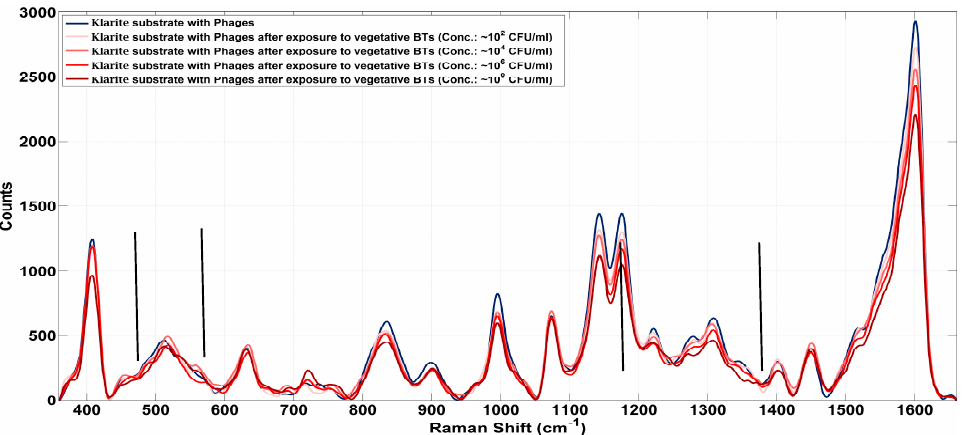
Figure 1. SERS spectra acquired on the Klarite ® SERS substrates functionalized with specific phages substrate (blue line) compared to the same Klarite ® SERS substrates inoculated with Bacillus thuringiensis (BT) cells at increasing